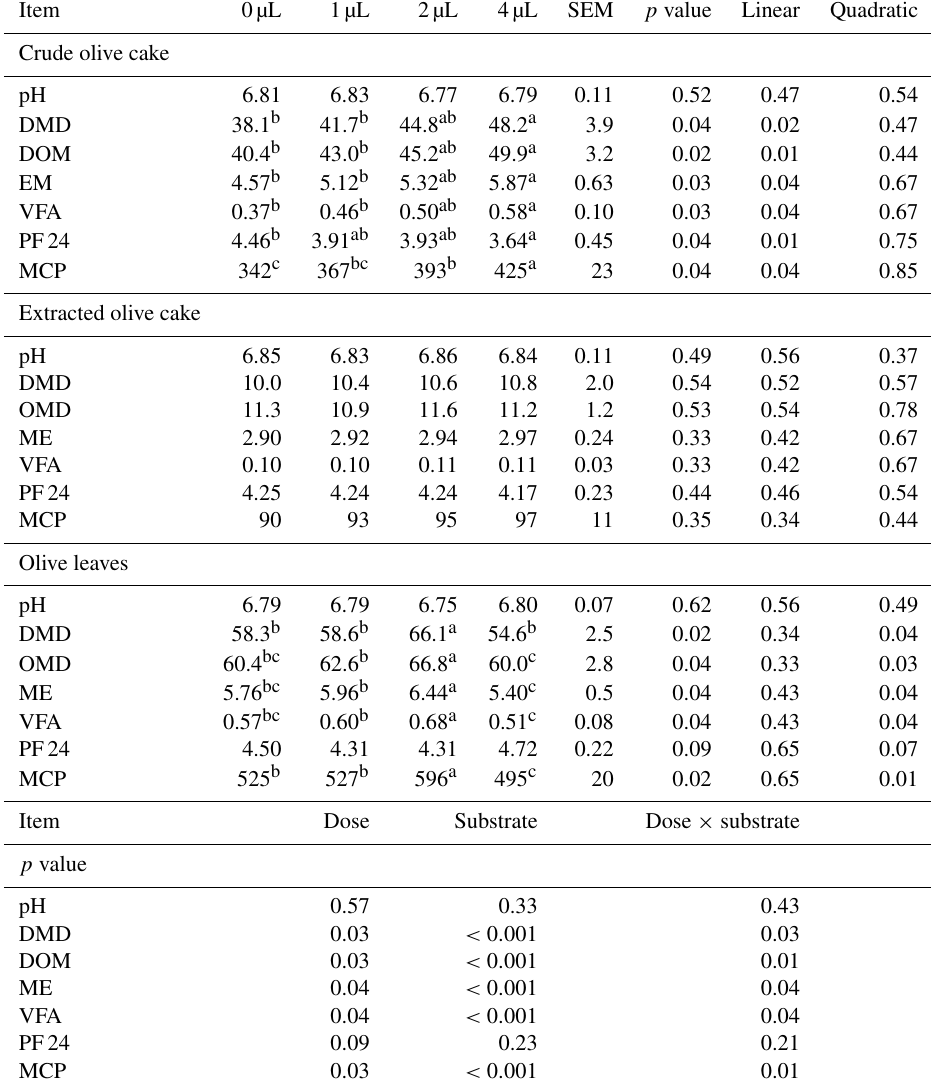
Table 4. Effect of exogenous fibrolytic enzymes on fermentation characteristics of olive mill waste.